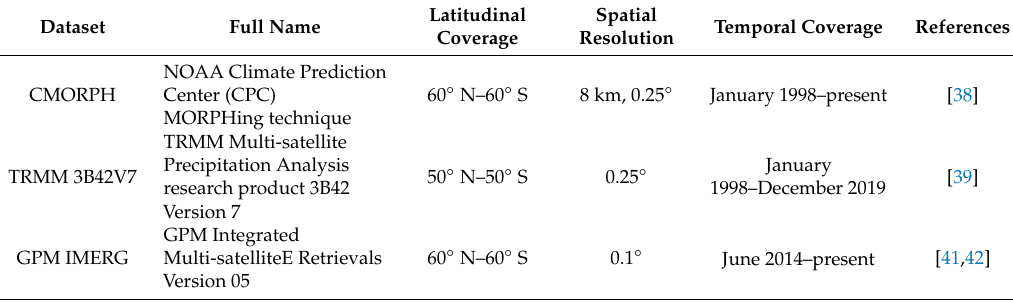
Table 1. Summary of satellite-based products providing data at a quasi-global scale.